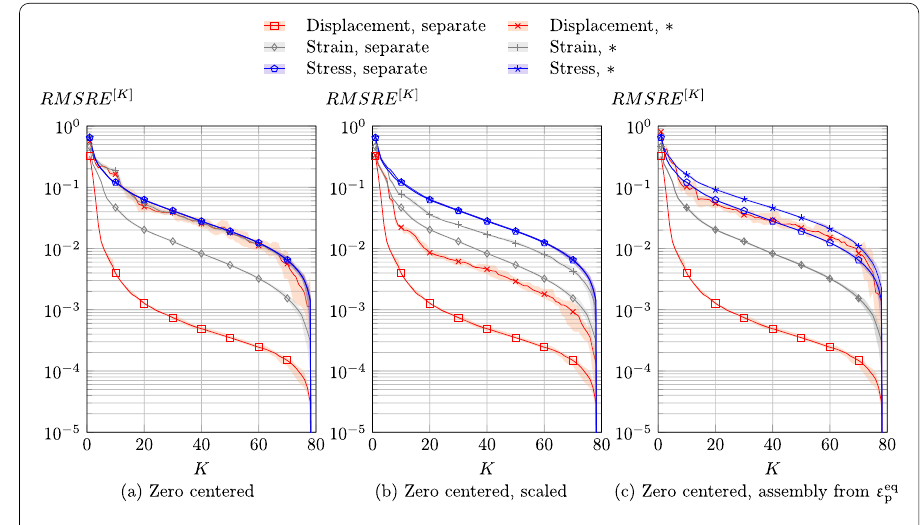
Fig. 7 Truncation error ( κ RMSRE [ K ] ) using different methods compared to separate decomposition of the industrial bending problem. The solid line represents the mean over the 5 training sets with markers every 10 basis vectors. The shaded area represents the range over all training